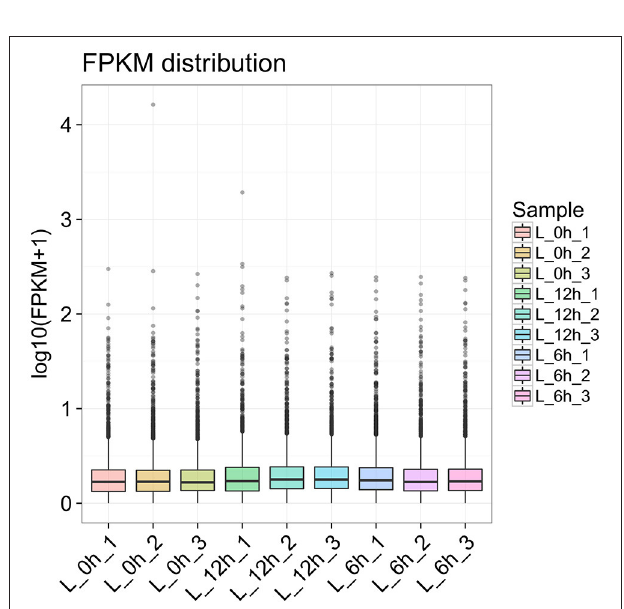
The obtained clean reads were mapped to the internal reference